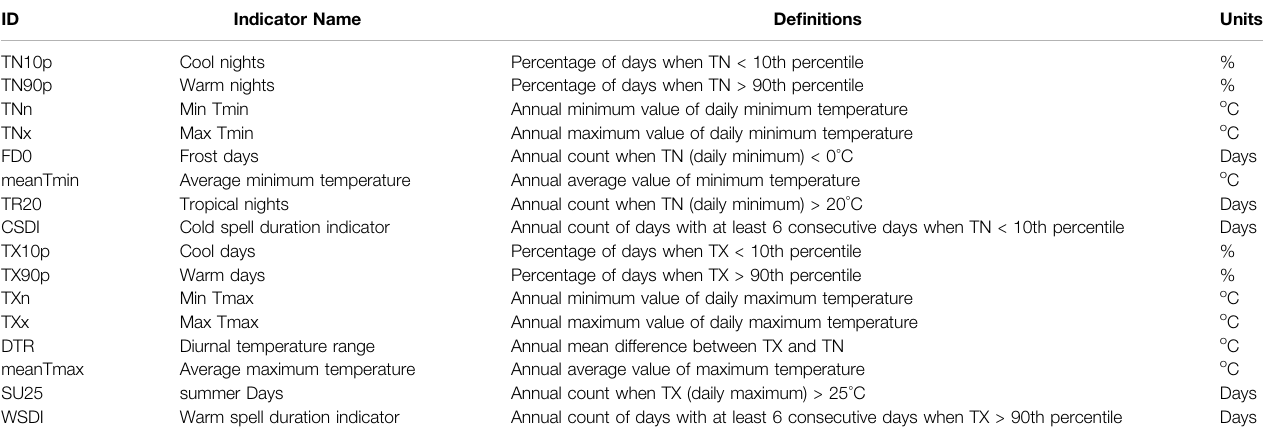
TABLE 4 | Extreme temperature indices used to assess climate change impact in